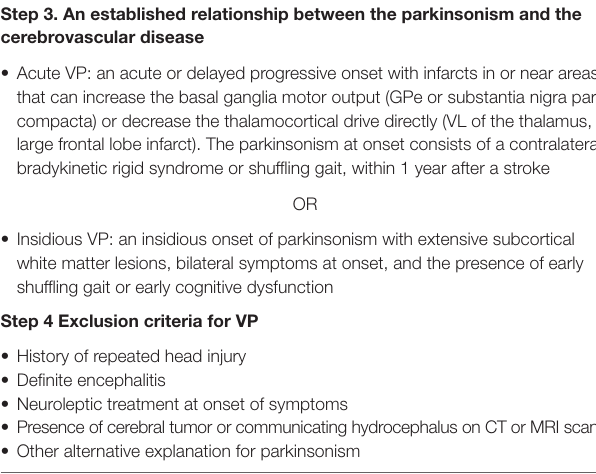
taBle 2 | Winikates’ vascular parkinsonism